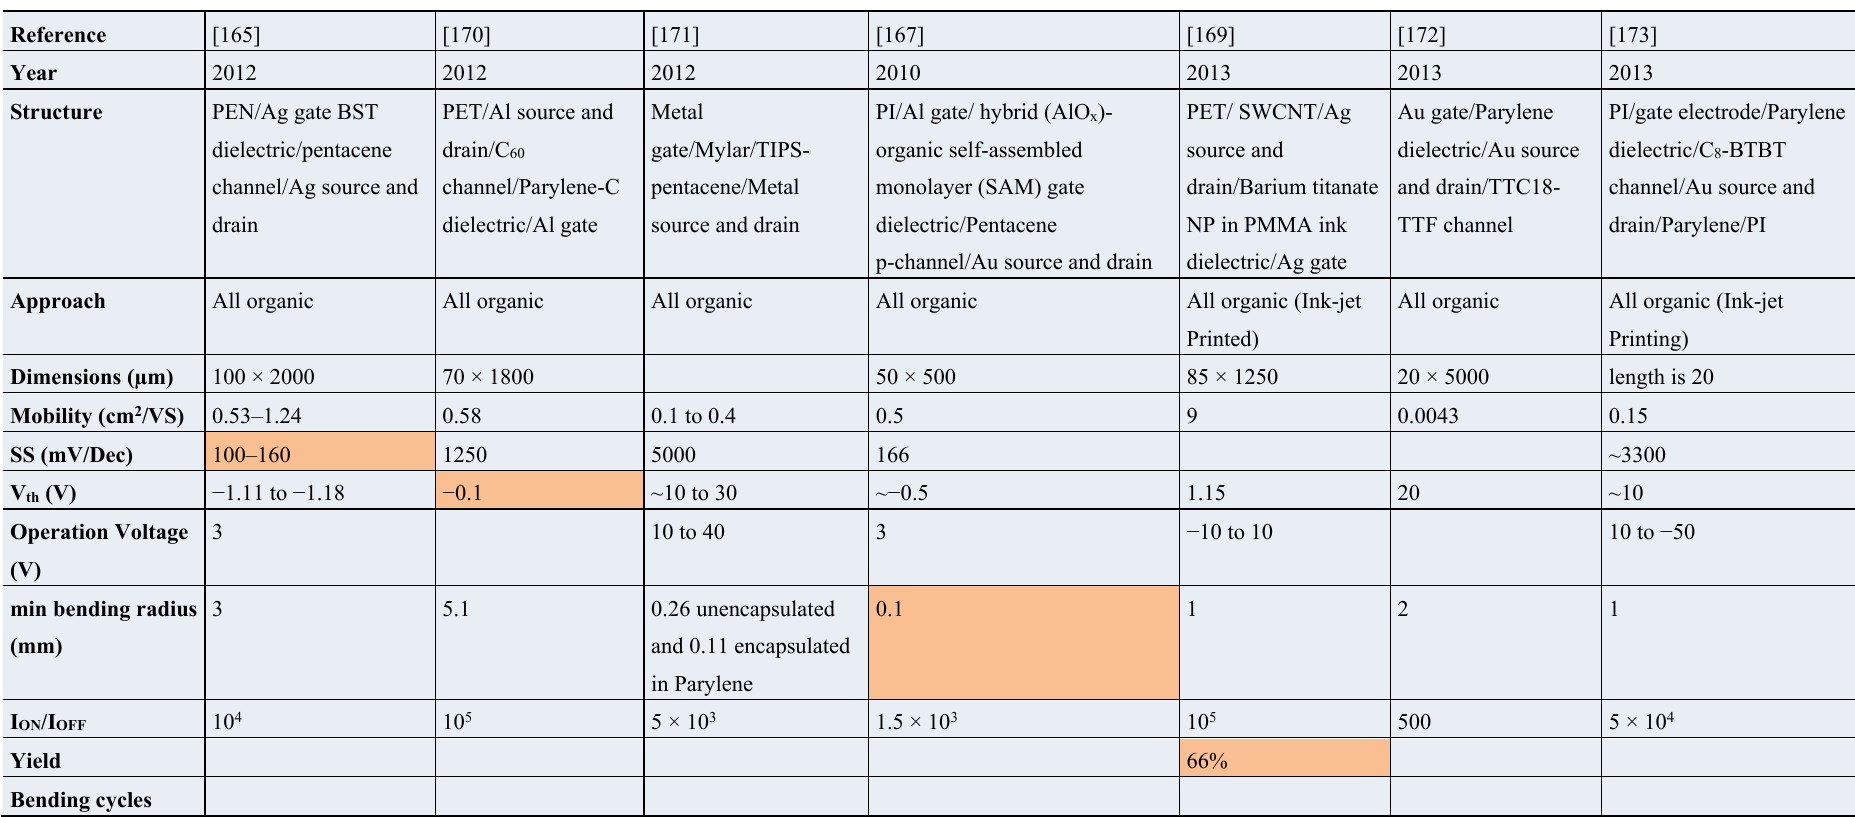
Table 2. Key works on flexible all-organic transistors from 2010 up to May 2015. Highlights showing the best values